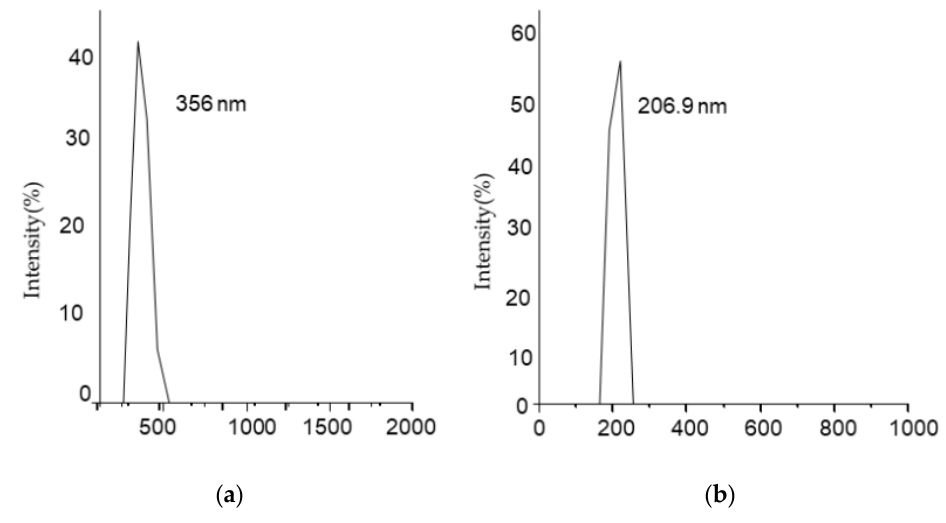
Figure 5. Dynamic light scattering (DLS) measurement for ( a ) Fe 3 O 4 and ( b ) Fe 3 O 4 @SiO 2 @APTES.